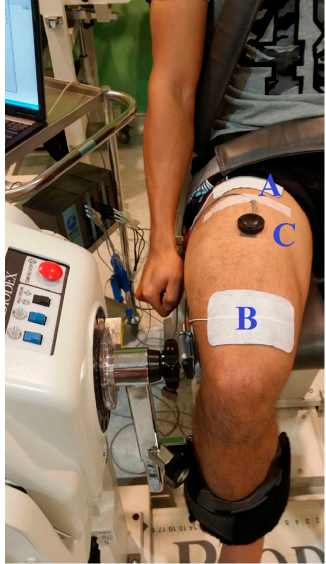
Figure 1. Experimental set-up at 90° knee angle showing the arrangement of stimulation electrodes ( A ) cathode, ( B ) anode Neuromuscular Electrical Stimulation (NMES) electrodes, and ( C ) Mechanomyographic signal (MMG) sensor in a representative participant.